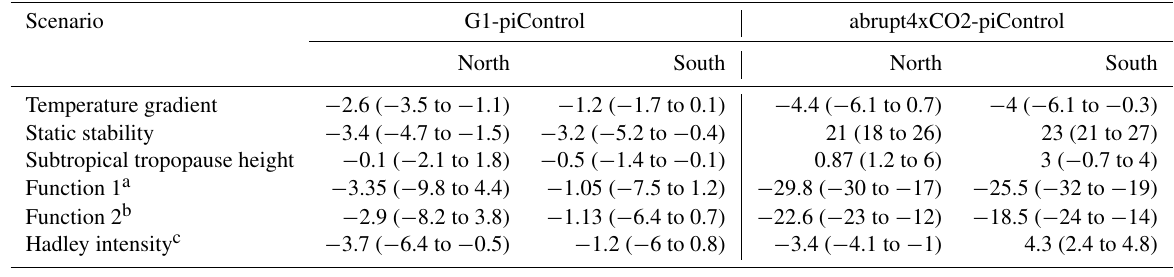
Table 3. The percentage changes in G1-piControl and abrupt4xCO2-piControl relative to piControl in the four-model (BNU-ESM, IPSL- CM5A-LR, HadGEM2-ES, MIROC-ESM) ensemble mean, with the across-model range in brackets. Functions 1 and 2 are scale factors for the Hadley circulation (Seo et al.,